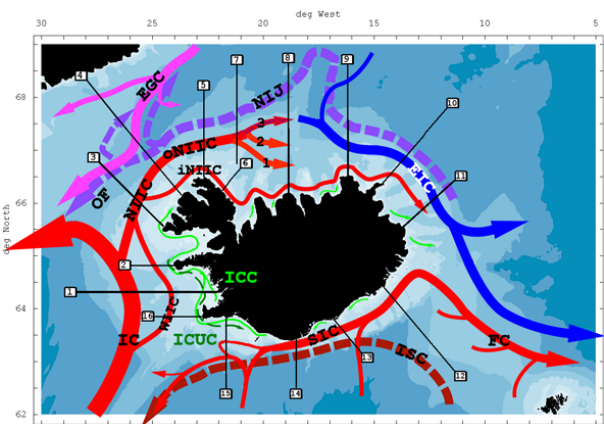
Fig. 6. Simulated mean flow field around Iceland at 15m depth, av- eraged over the period 1992 to 2006 and bottom topography (1500, 1000, 500 and 200m isobaths).